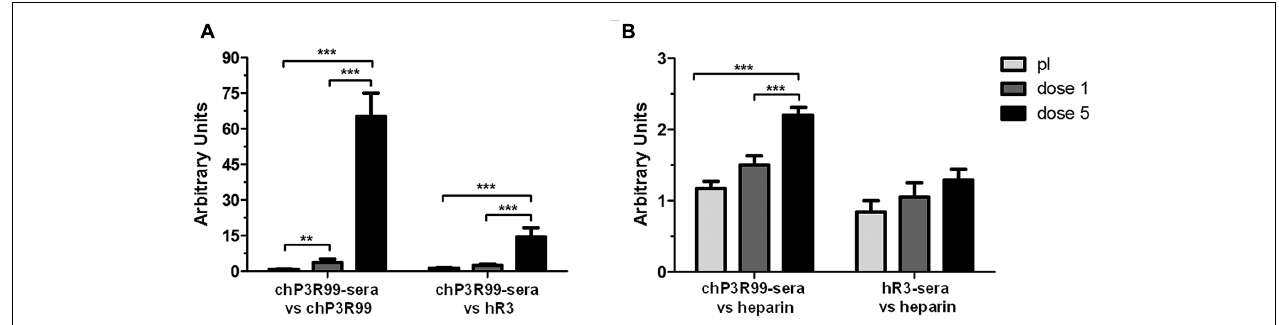
FIGURE 2 | Induction of anti-idiotype and anti-heparin antibodies in apoE − / − mice treated with chP3R99. Sera (diluted 1:400), collected before starting treatment (pI, preimmune) and 7 days after the first and the last administration of chP3R99 or isotype-matched control hR3, were added to chP3R99/hR3 − or heparin-coated ELISA plates. Specific antibodies were revealed by peroxidase-conjugated goat anti-mouse IgG polyclonal secondary antibodies. (A) Reactivity of sera from chP3R99-treated mice against chP3R99 (anti-idiotype + anti-isotype response) or hR3 (anti-isotype response). A ratio of chP3R99-associated reactivity to hR3-associated reactivity of 2.5-fold or higher was considered as immunodominant induction of anti-idiotype antibodies. (B) Reactivity of sera from chP3R99 − or hR3-treated mice against heparin. Reactivity levels are expressed as arbitrary units. Results are mean ± SEM. The data are representative of three independent experiments. ∗∗ p < 0.01, ∗∗∗ p < 0.001, one-way ANOVA followed by Tukey’s post hoc